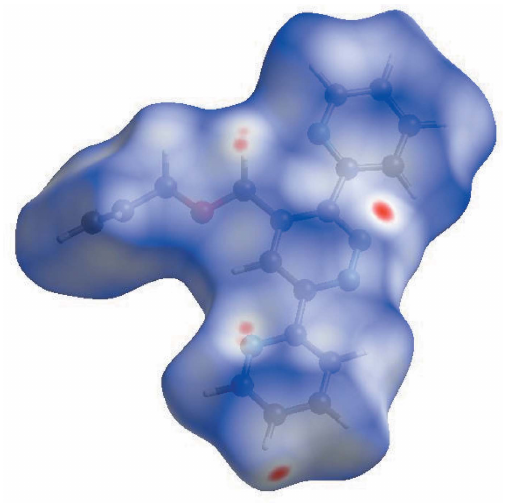
Figure 4 View of the three-dimensional Hirshfeld surface of the title compound plotted over d norm in the range (cid:4) 0.1063 to 1.1444 a.u.